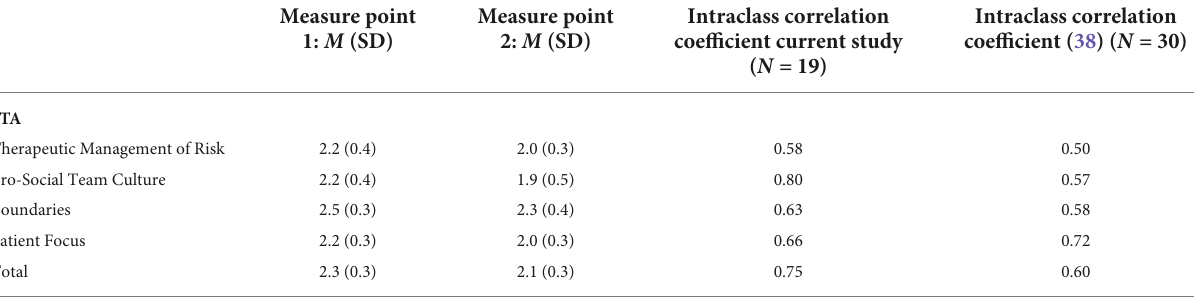
TABLE 4 Test-retest reliability of the STA